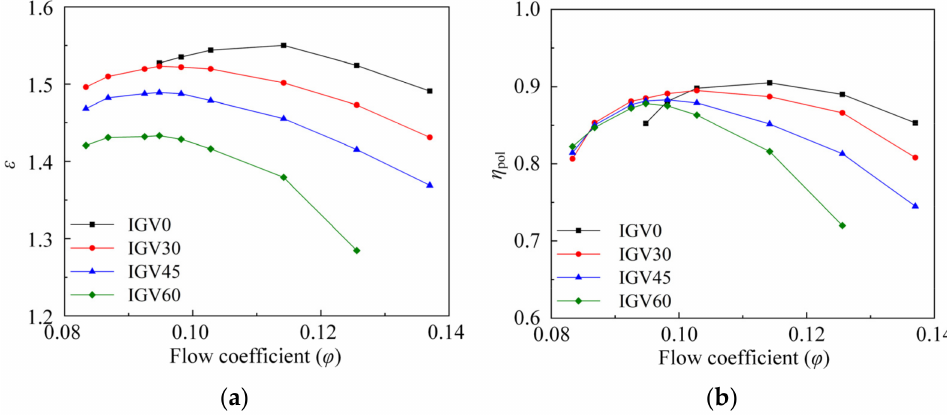
Figure 6. The performance map under different IGVs openings: ( a ) total pressure ratio; ( b ) polytropic efficiency.